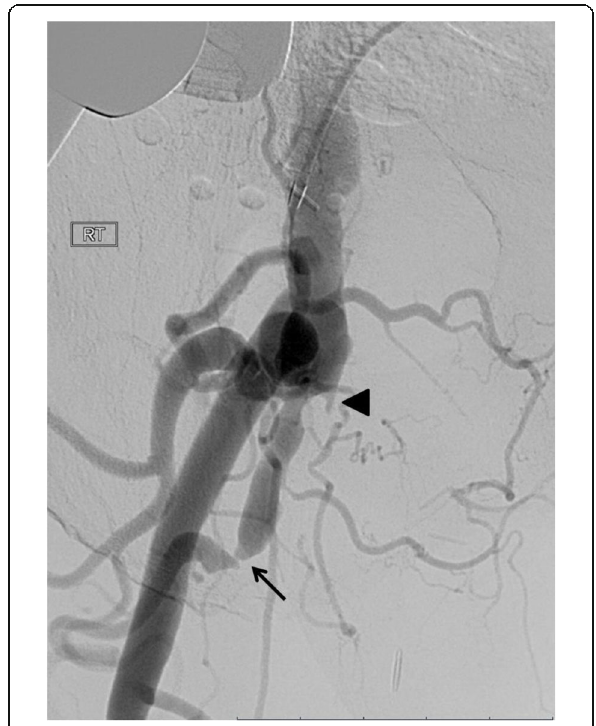
Fig. 1 Baseline angiogram showing the native superficial femoral artery occluded few centimetres after the origin (arrow) with a big collateral coming off from the stump. A small stump of the previous femoro-popliteal bypass is also visible (arrow head)